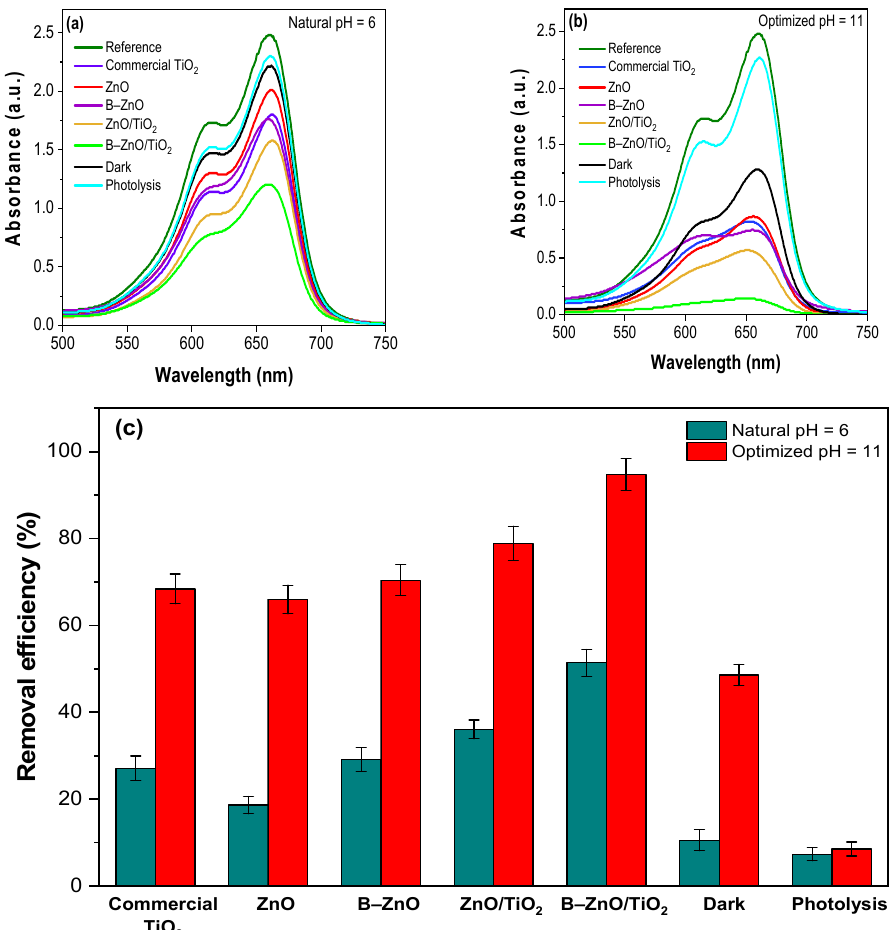
Figure 8. ( a , b ) UV–visible results showing the decay in the intensity of MB solution; ( c ) Photocatalytic removal, adsorption under dark, and photolysis for MB (initial MB concentration: 15 mg/L; photocatalyst amount: 30 mg; pH: 6 and 11; irradiation time: 15 min).